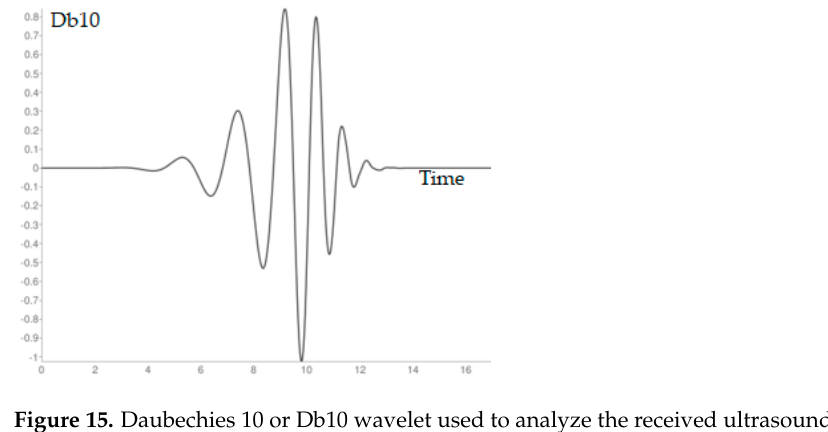
Figure 15. Daubechies 10 or Db10 wavelet used to analyze the received ultrasound signal.